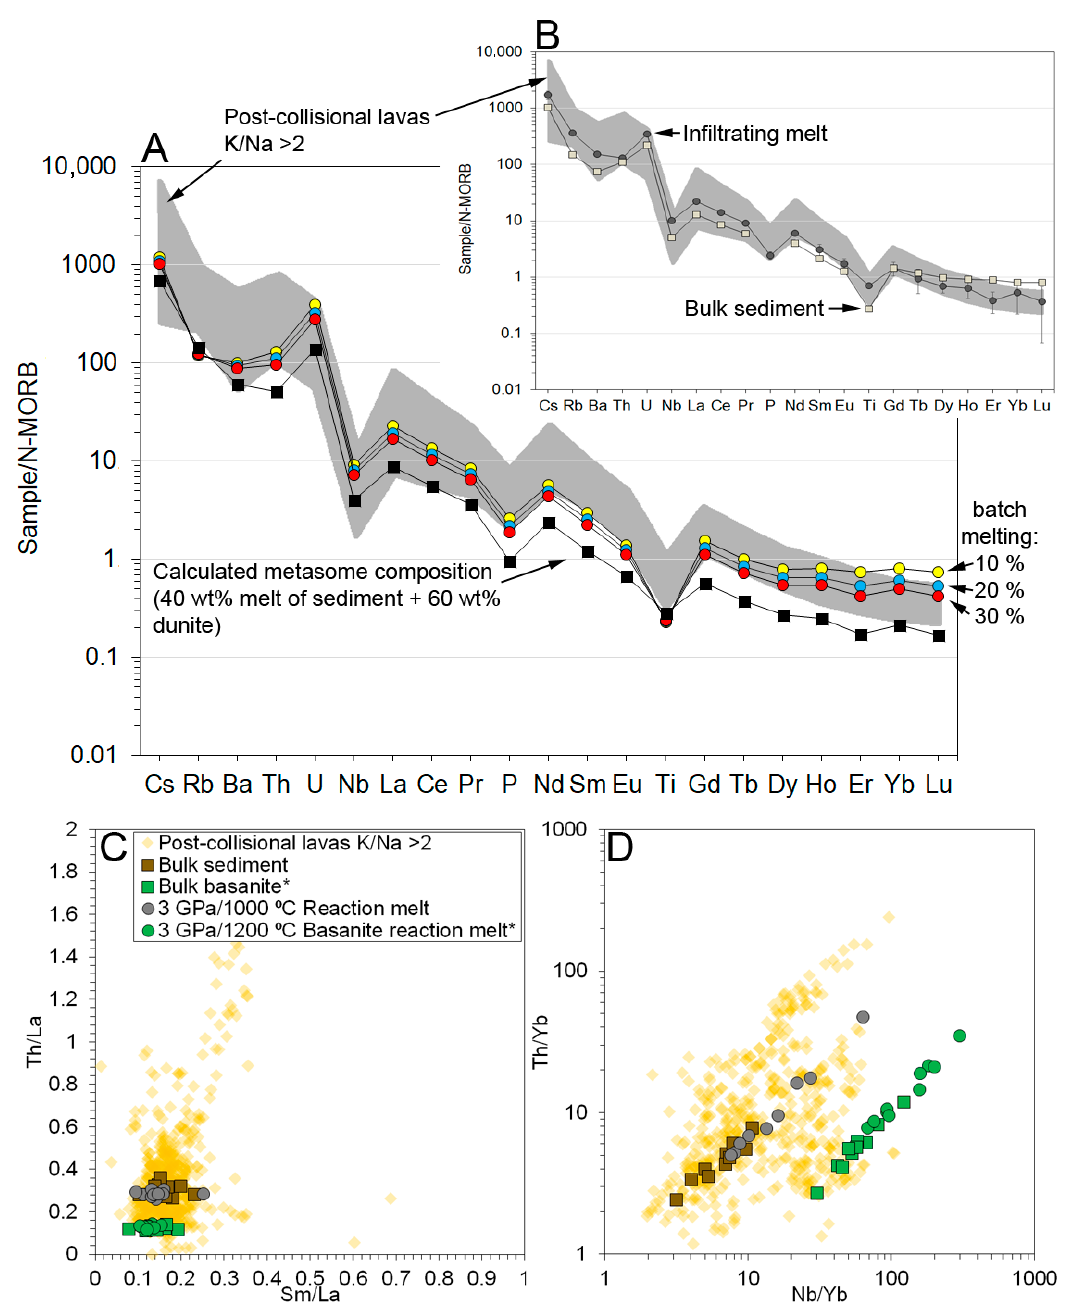
Figure 5. N-MORB normalized trace element compositions of ( A ) modelled batch melt compositions and (B) starting materials [67] (grey squares, sediment) compared with experimental melts (grey circles, 3 GPa/1000 °C) and post-collisional lavas (shaded area) [9]. The sediment/dunite reaction melts ( B ) are rich in Cs, Rb, and Ba, and show negative anomalies at Nb, P, and Ti, similar to post-collisional lavas with K/Na > 2. ( A ) Forty weight percent melt of sediment reacts with 60 wt% dunite to form the calculated metasome composition. Batch melting of the metasome (10%–30%) increases the trace element mass fractions to values observed within post-collisional lavas. ( C ) Th/La versus Sm/La shows experimental 3 GPa/1000 °C sediment/dunite reaction melts at Th/La 0.2–0.6, plotting with the bulk of post-collisional lavas [9], while peridotite melts such as basanite/dunite reaction melts plot at Th/La <0.2 [53]. ( D ) Th/Yb versus Nb/Yb of sediment/dunite reaction melts plot with post-collisional lavas, while basanite/dunite reaction melts attain higher Nb/Yb ratios and plot largely outside the field of post-collisional lavas [53].